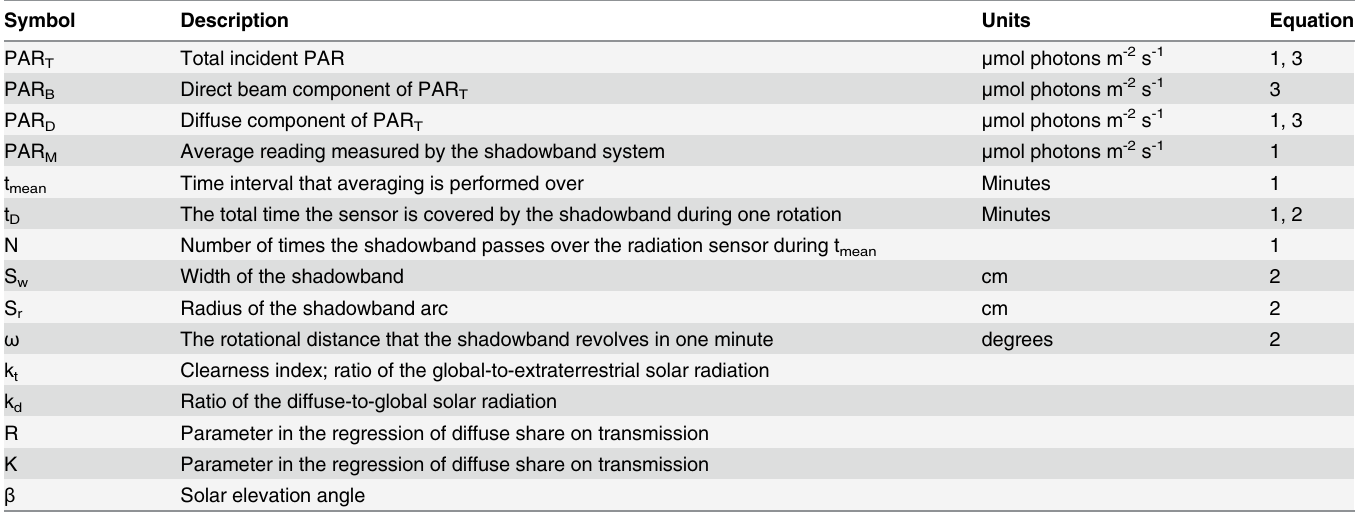
Table 1. De fi nition of